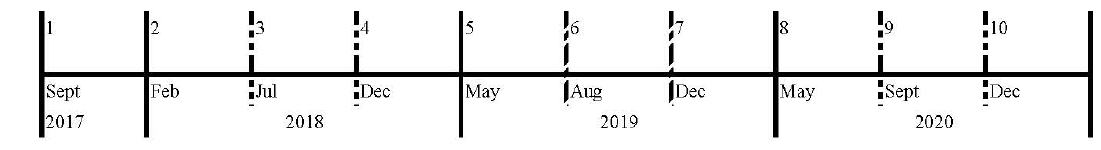
Figure 1. The 10 study assessment timepoints from 2017 to 2020.